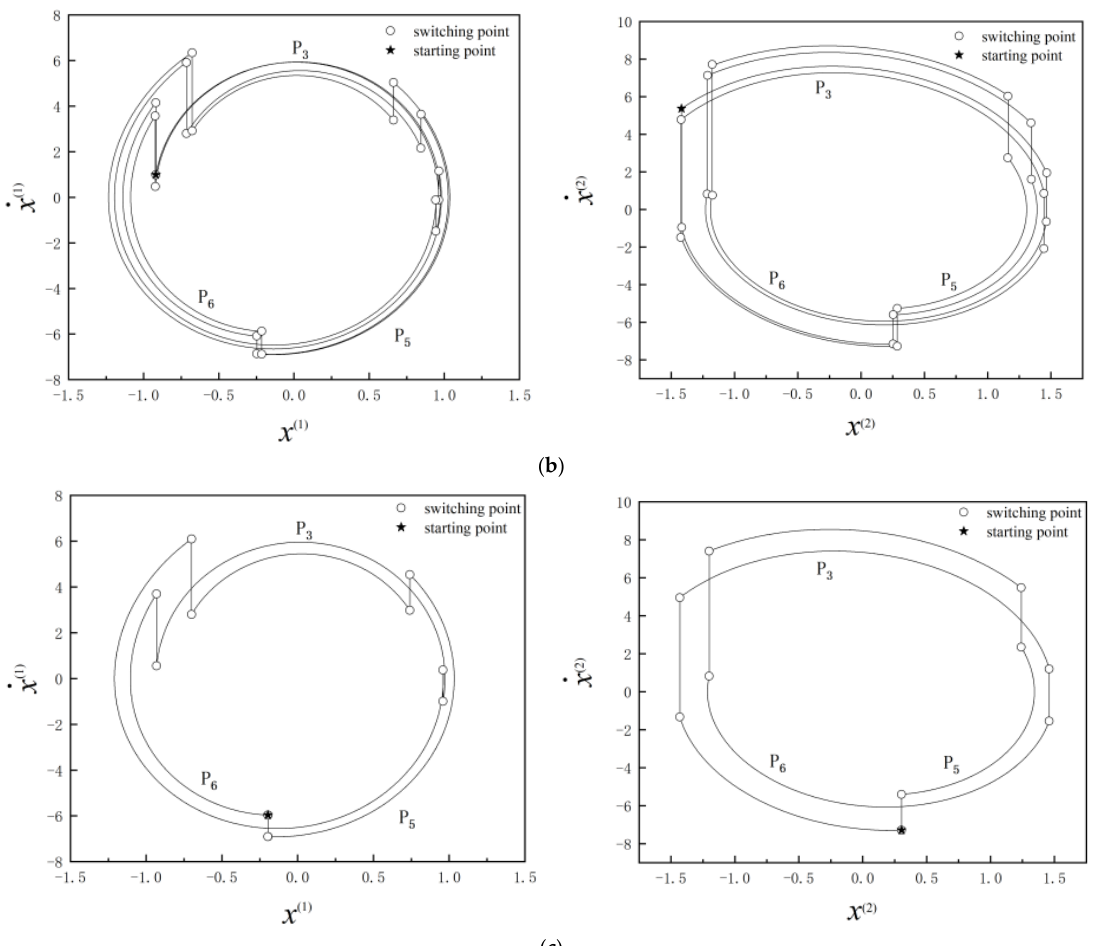
Figure 8. Inverse bifurcation. ( a ) e = 0.854, ( b ) e = 0.854, ( c ) e = 0.875.